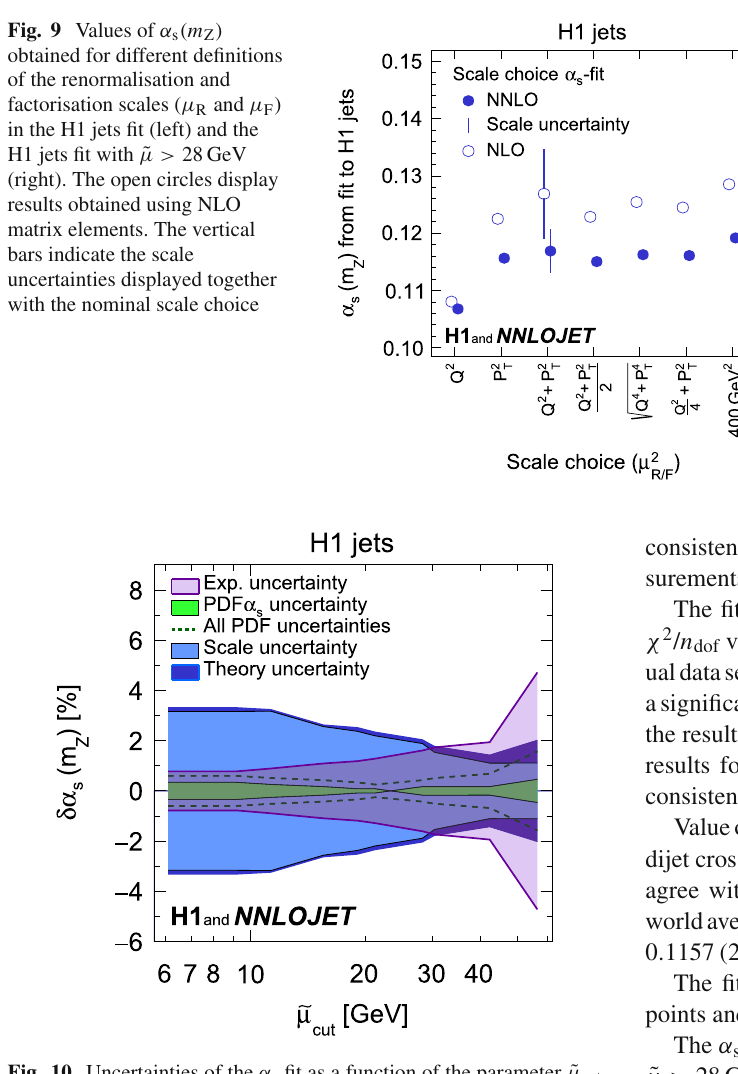
Fig. 10 Uncertainties of the α s fit as a function of the parameter ˜ μ cut which restricts the jet data to high scales. The experimental, scale, PDF α s , quadratic sum of all PDF related uncertainties, and the theory uncertainty are